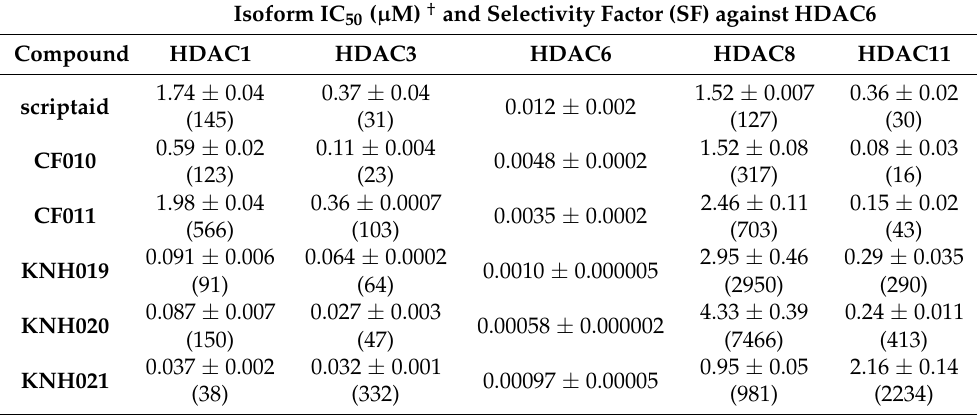
Table 4. HDAC activity (IC 50 ) and isoform selectivity factor for 3-amido scriptaid